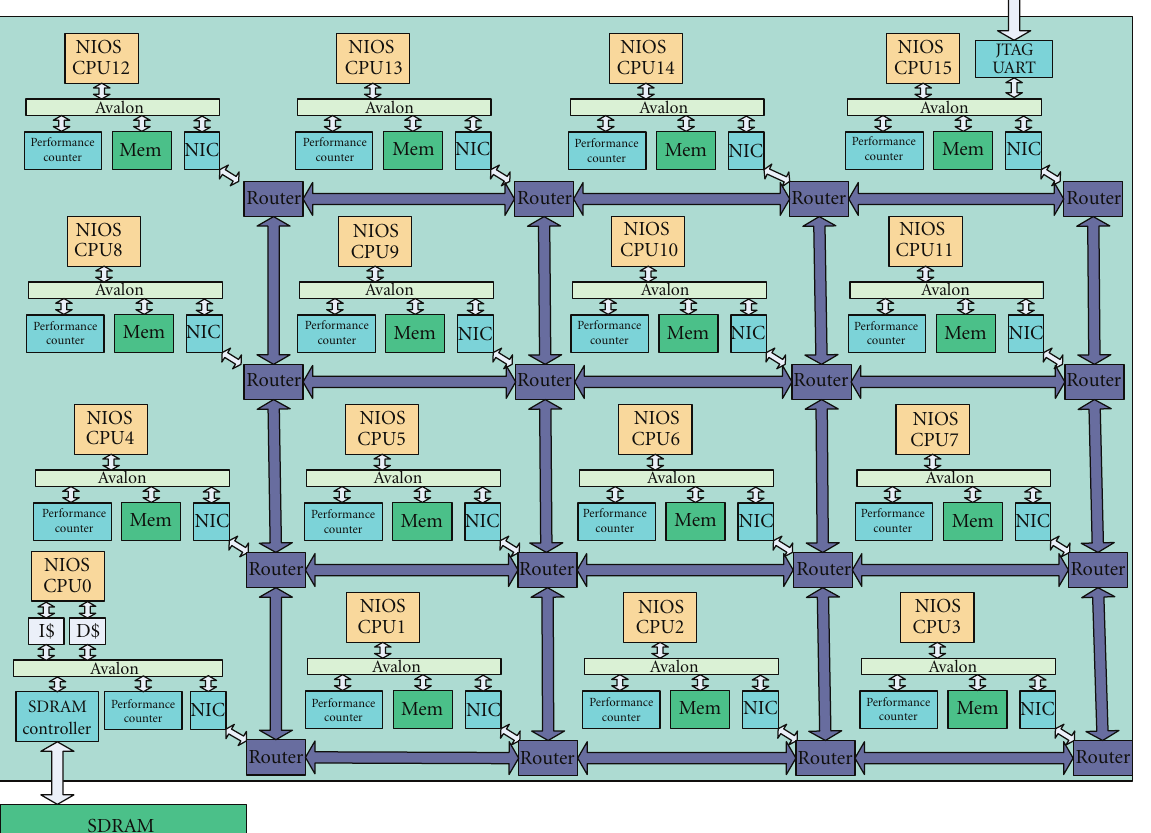
Figure 11: Large distributed memory architecture